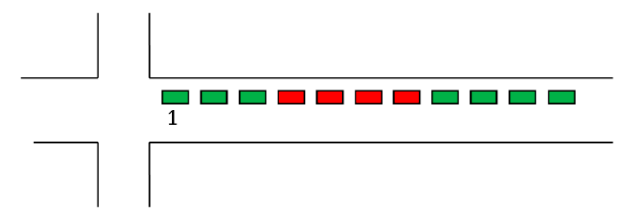
Figure 13. Four vehicles not equipped with proposed solution (in red) among series of cars with working sound notification system (in green).